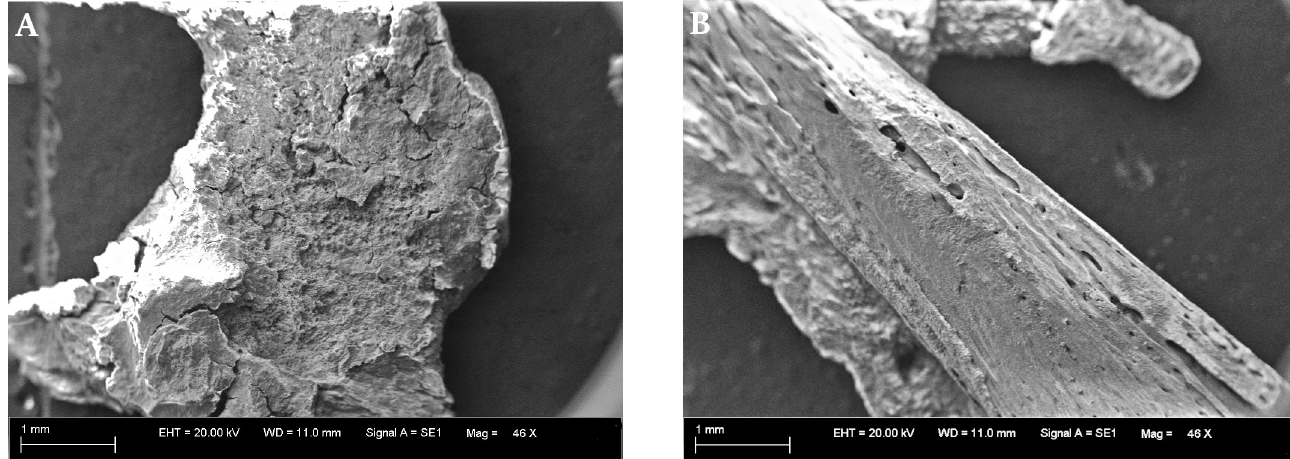
Fig 7. SEM images of the shell’s inner surface with irregular structures and surface porosity (A) and tibia surface with visible compact tissue and cancellous tissue (B).